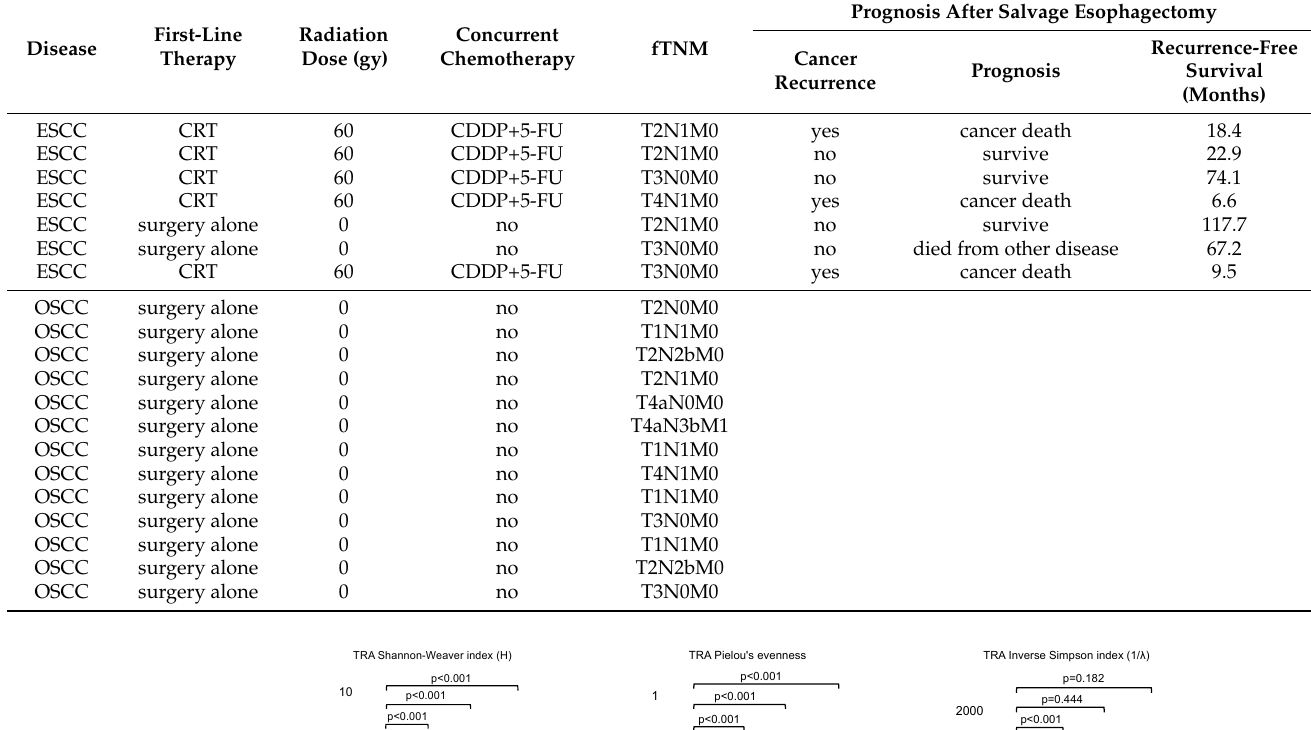
the Shannon-Weaver index H for TRB , p = 0.525 for inverse Simpson (1/ λ ) for TRB , and p = 0.460 in Pielou’s evenness for TRB ). Table 1. The clinical and pathologic data of patients with esophageal squamous cell carcinoma (ESCC) or with oral squamous cell carcinoma (OSCC) examined in this study. CRT: chemoradiation therapy.